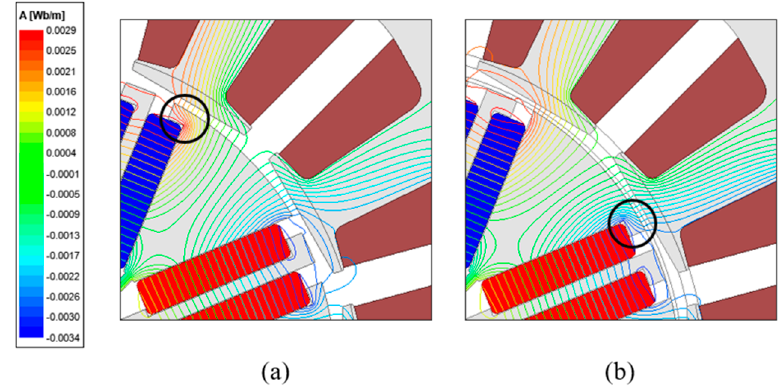
Figure 3. Magnetic flux line. ( a ) Stack No.1; ( b ) Stack No.2.